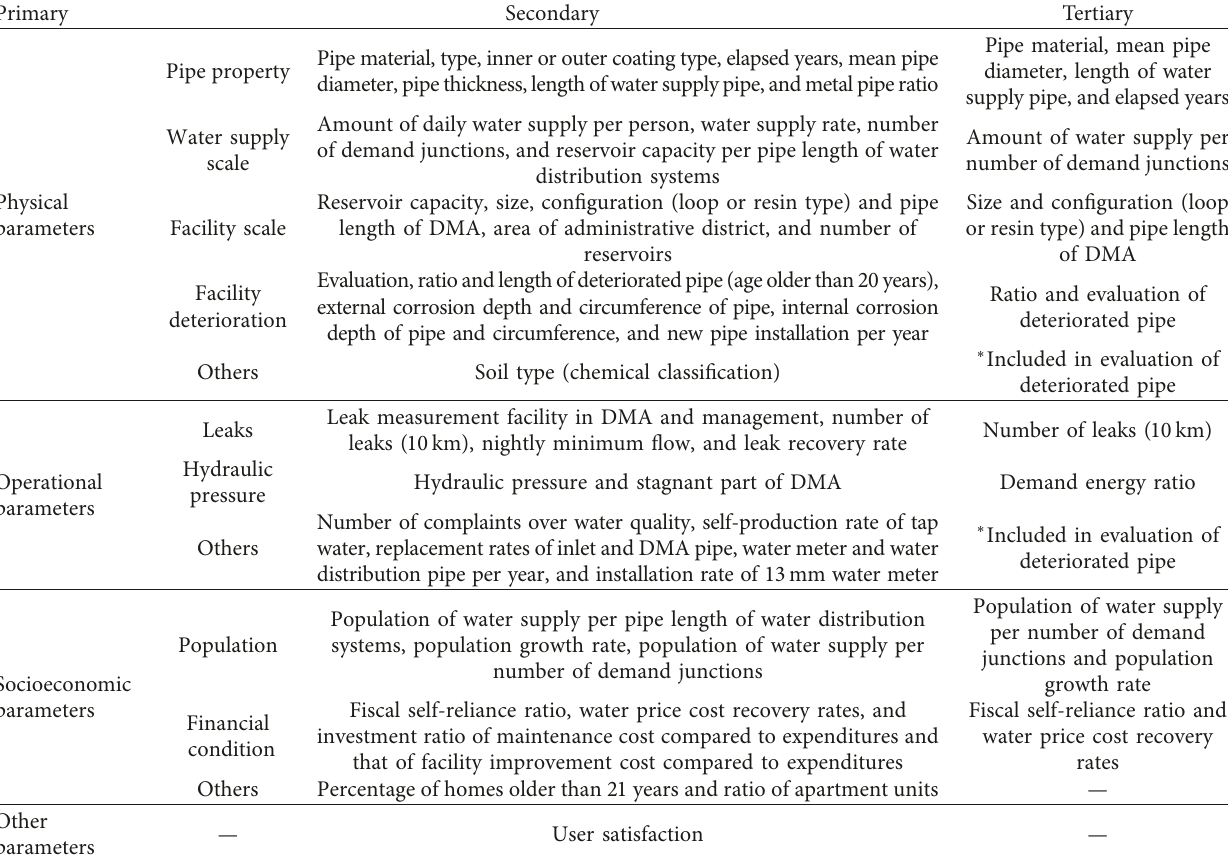
Table 5: Classification of effective parameters suggested for NRW management [4, 8,